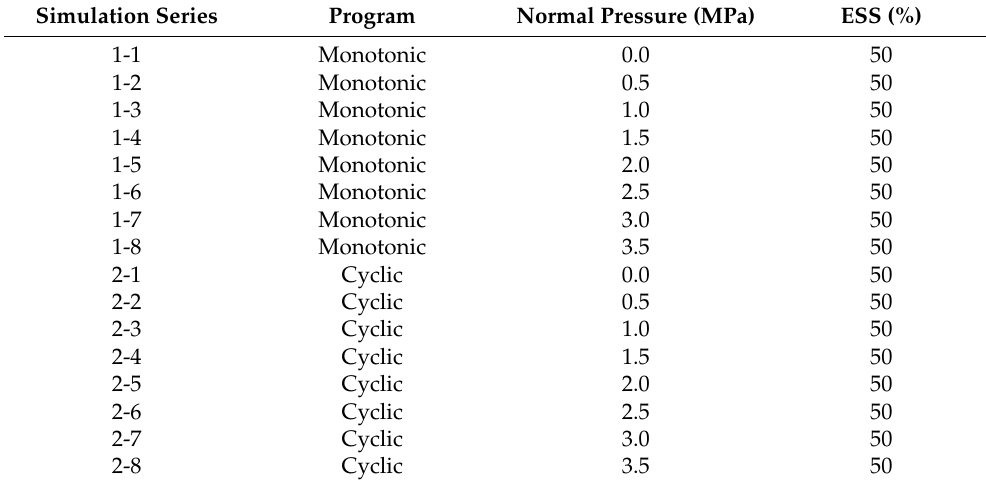
Table 1. Simulation programs.